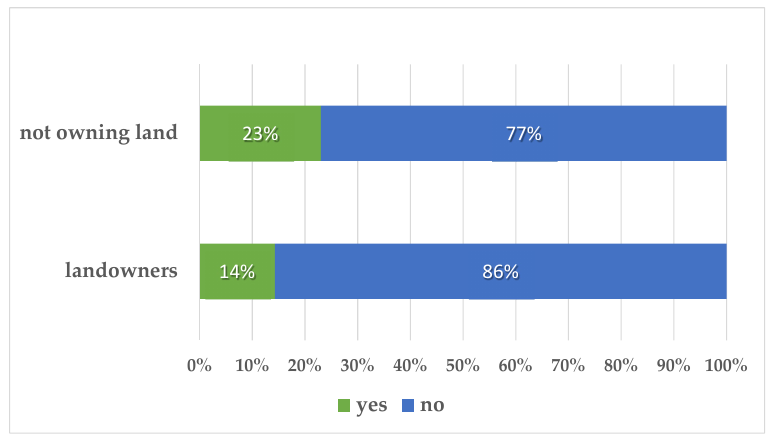
Figure 2. Would you consider leaving your village in the next 3